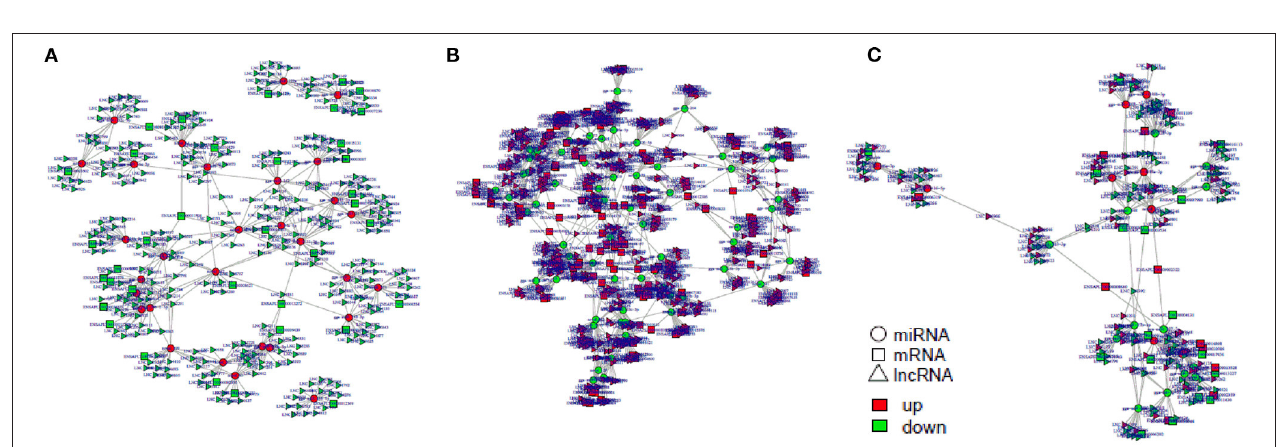
FIGURE 10 | The regulatory networks of lncRNA-miRNA-mRNA during SE infection in duck granulosa cells. (A) lncRNA-miRNA-mRNA interaction network of 3 vs. 0 hpi group. (B) lncRNA-miRNA-mRNA interaction network of 6 vs. 0 hpi group. (C) lncRNA-miRNA-mRNA interaction network of 6 vs. 3 hpi group.